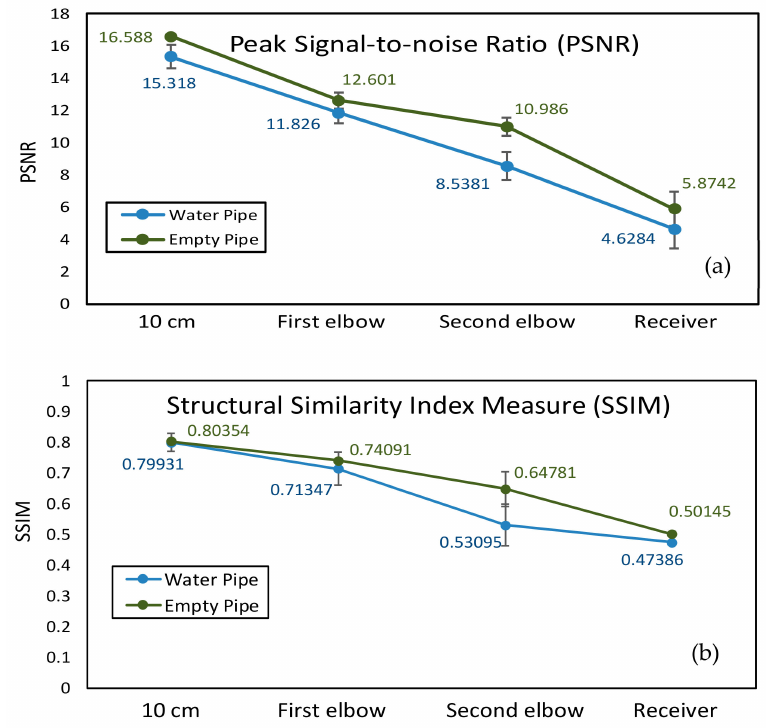
Figure 9. ( a ) PSNR performance and ( b ) SSIM performance for AISRT